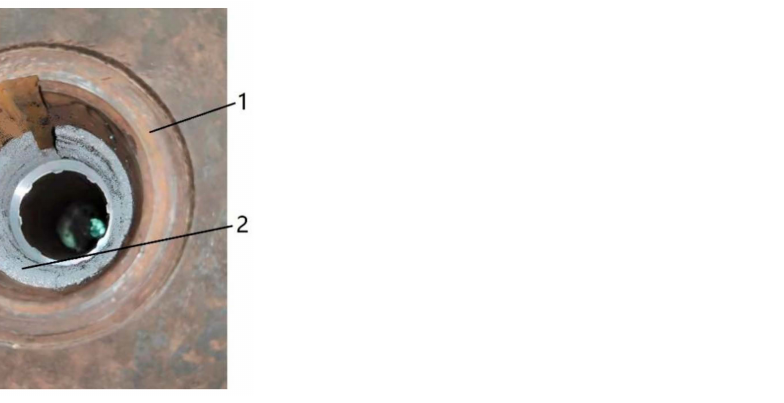
Figure 10. Mounting position of the damping ring of the hob shaft sleeve. (1) Hob shaft sleeve; (2) damping ring.